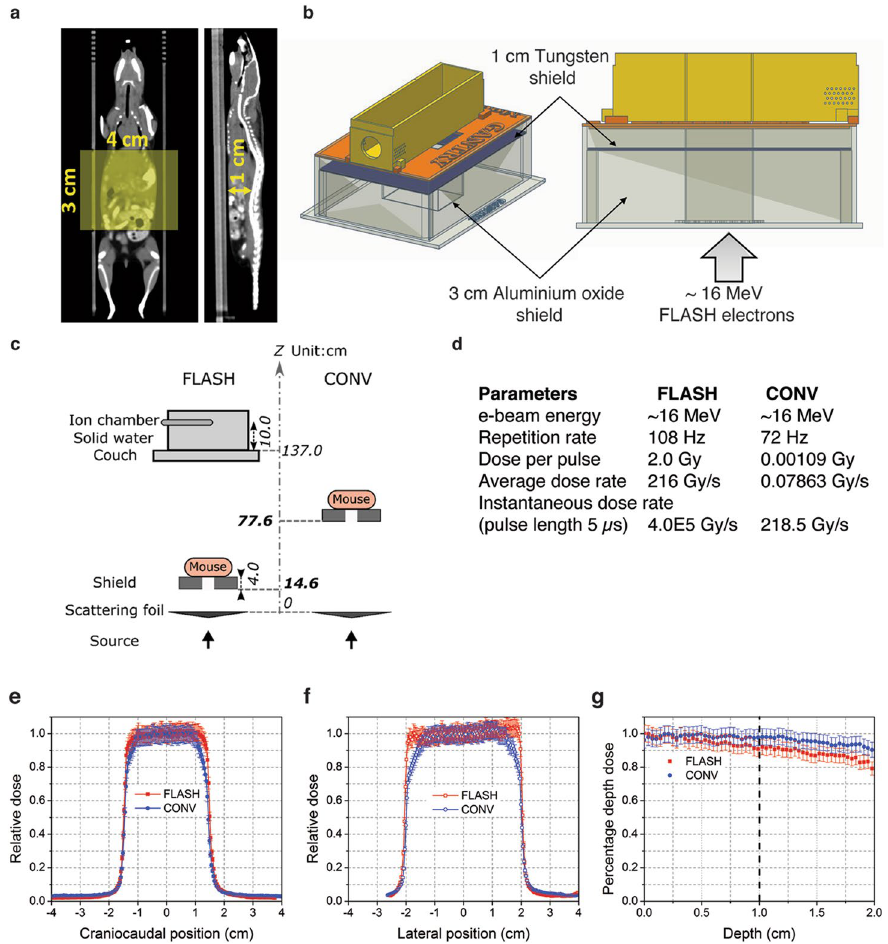
Figure 1. Experimental platform for ultra-high dose rate FLASH and conventional abdominal irradiation. ( a ) CT images (coronal and sagittal slices) showing reproducible mouse positioning within the stereotactic frame. The yellow shaded rectangle (3 cm × 4 cm) indicates the irradiated region in the abdomen; the 3 cm length with the cranial border at the 10 th rib encompasses the entire small bowel. The distance from the abdominal wall to the ventral surface of the spine, representing the most posterior extent of the abdominal cavity, is 1 cm (yellow arrow). ( b ) Design of 3-D printed PLA plastic mouse stereotactic positioning frame and abdominal irradiation shield comprising a 3-D printed PLA plastic shell containing layers of 3 cm thick aluminum oxide (Al 2 O 3 ) powder in tandem with a mixture of 1 cm thick tungsten beads (2 mm diameter) and powder. The Al 2 O 3 layer slows down the ~ 16 MeV primary electrons and the tungsten layer stops the transmitted electrons and attenuates the bremsstrahlung x-rays produced by the electron beam. ( c , d ) Schematic of the geometric and beam parameters for FLASH and CONV setups. The shorter distance from the electron scattering foil and higher charge per pulse in FLASH produces an average dose rate 2750 times the CONV dose rate. ( e ) Craniocaudal, ( f ) lateral profiles at the entrance surface, and ( g ) depth dose profiles for FLASH and CONV setups were recorded using EBT3 Gafchromic films between layers of polystyrene. The doses are uniformly distributed (within < 10% heterogeneity) within the abdominal